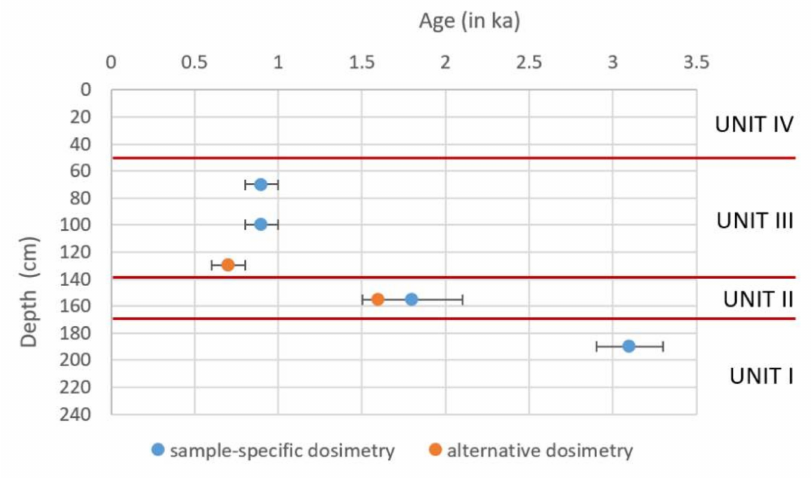
Figure 10. Age-depth profile for samples SUTL2361, 2362, 2363, 2390, and 2391 (see Table